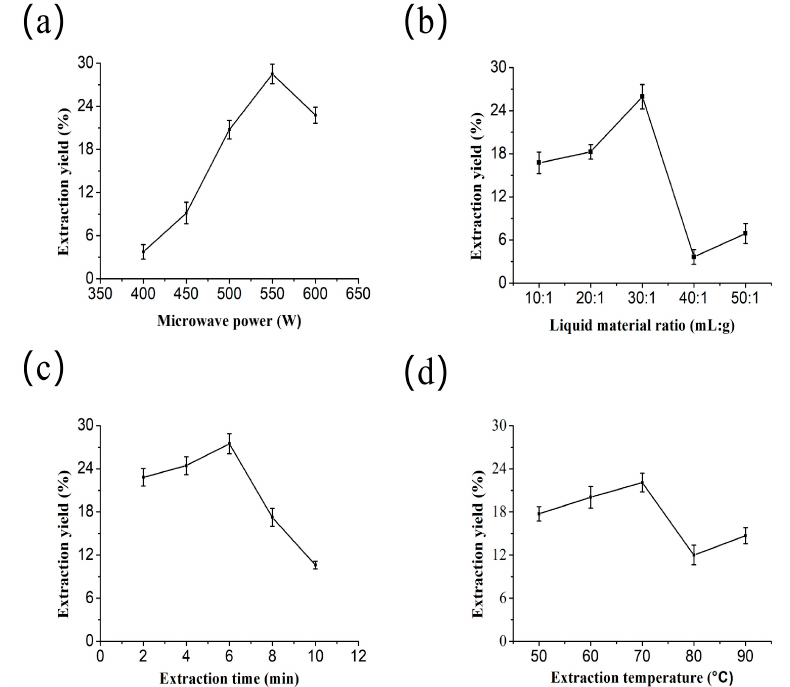
Figure 1. Effects of microwave power ( a ), liquid-to-material ratio ( b ), extraction time ( c ), and extraction temperature ( d ) on the extraction yield of microwave-assisted extraction used to prepare P. ginseng polysaccharides (MPPG). Data were expressed as the means ± SD ( n = 3).